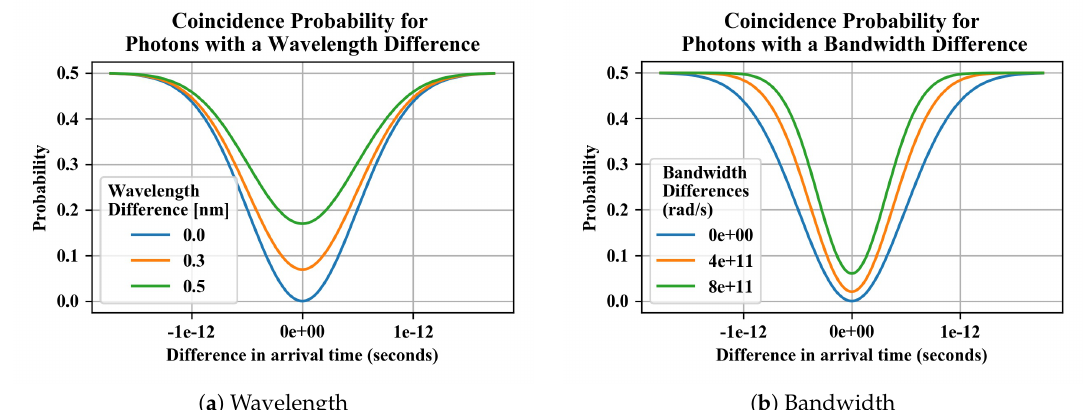
Figure 3. Coincidence probability as a function of beam splitter arrival time difference for photon pairs with varying degrees of distinguishability. The coincidence rate vanishes for perfectly identical photons arriving simultaneously, with the width of the HOM dip determined by the pulse bandwidth. ( a ) displays the coincidence probability curves for two photons with an identical bandwidth ∆ ω = 1.18 × 10 12 rad/s and different wavelengths. ( b ) uses two photons with an identical wavelength λ = 788 nm and different bandwidths, which center around ∆ ω = 1.18 × 10 12 rad/s. These parameters are chosen consistently with those of the simulations described in Section